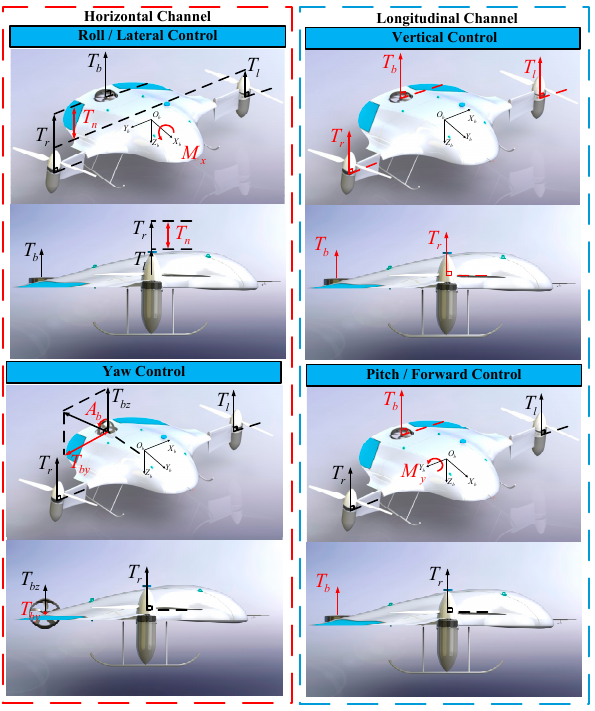
Figure 5. Control allocation strategy for the conventional scheme.